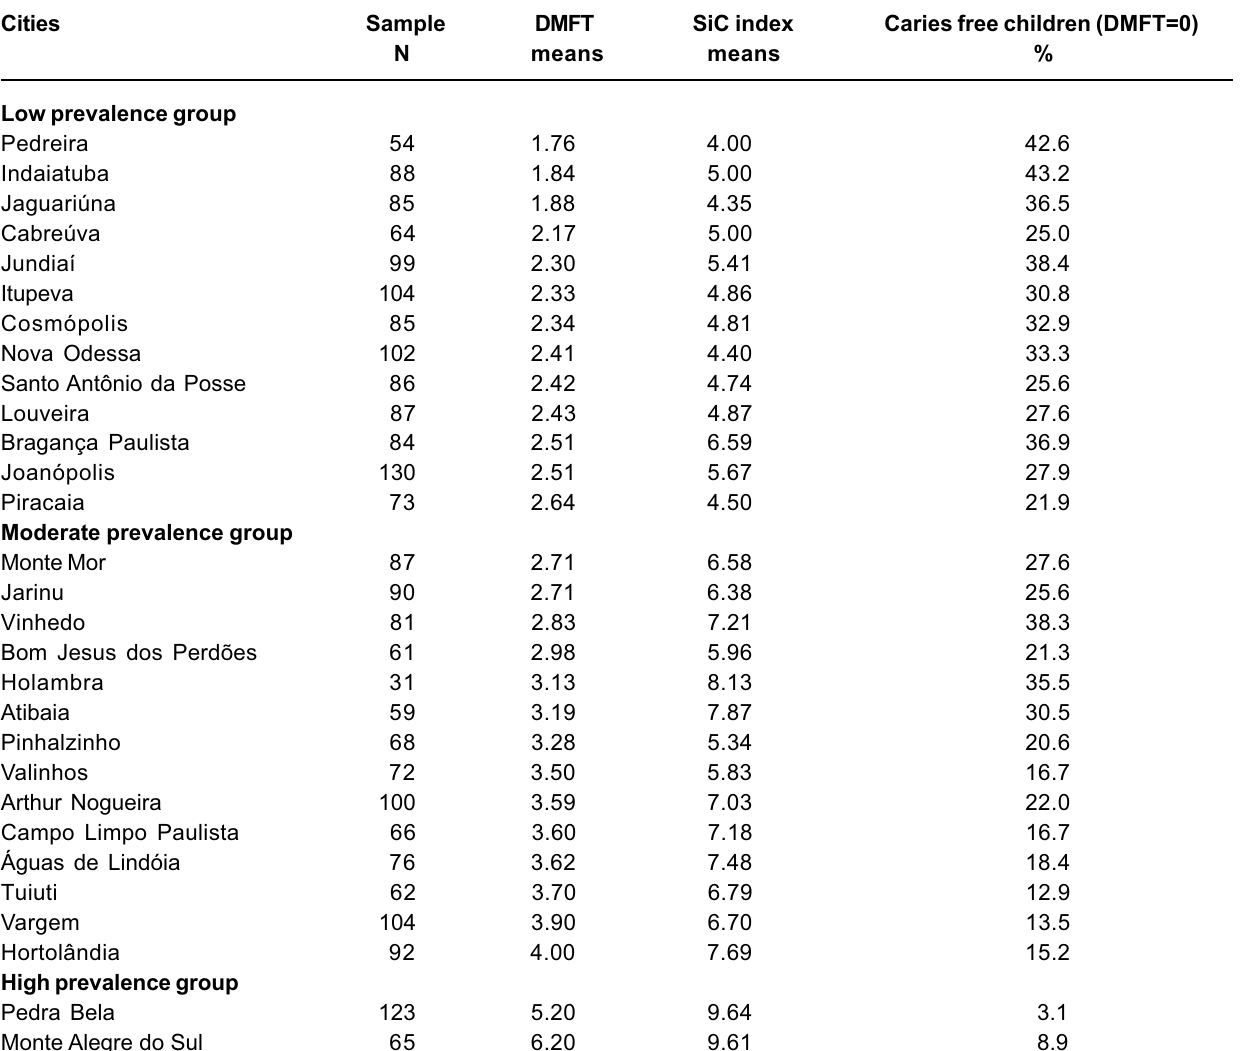
TABLE 1- Mean values for the DMFT, SiC indexes and caries-free percentage for 12-year-old children in the cities evaluated in the region of Campinas, São Paulo State, 1998 to